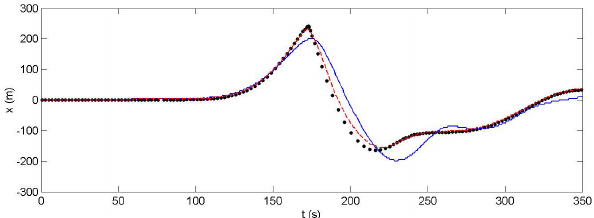
Fig. 3. Time series of shoreline positions given by the analytical solution ( (cid:5) ), simulated with the FB model (—) and non-dispersive model (-